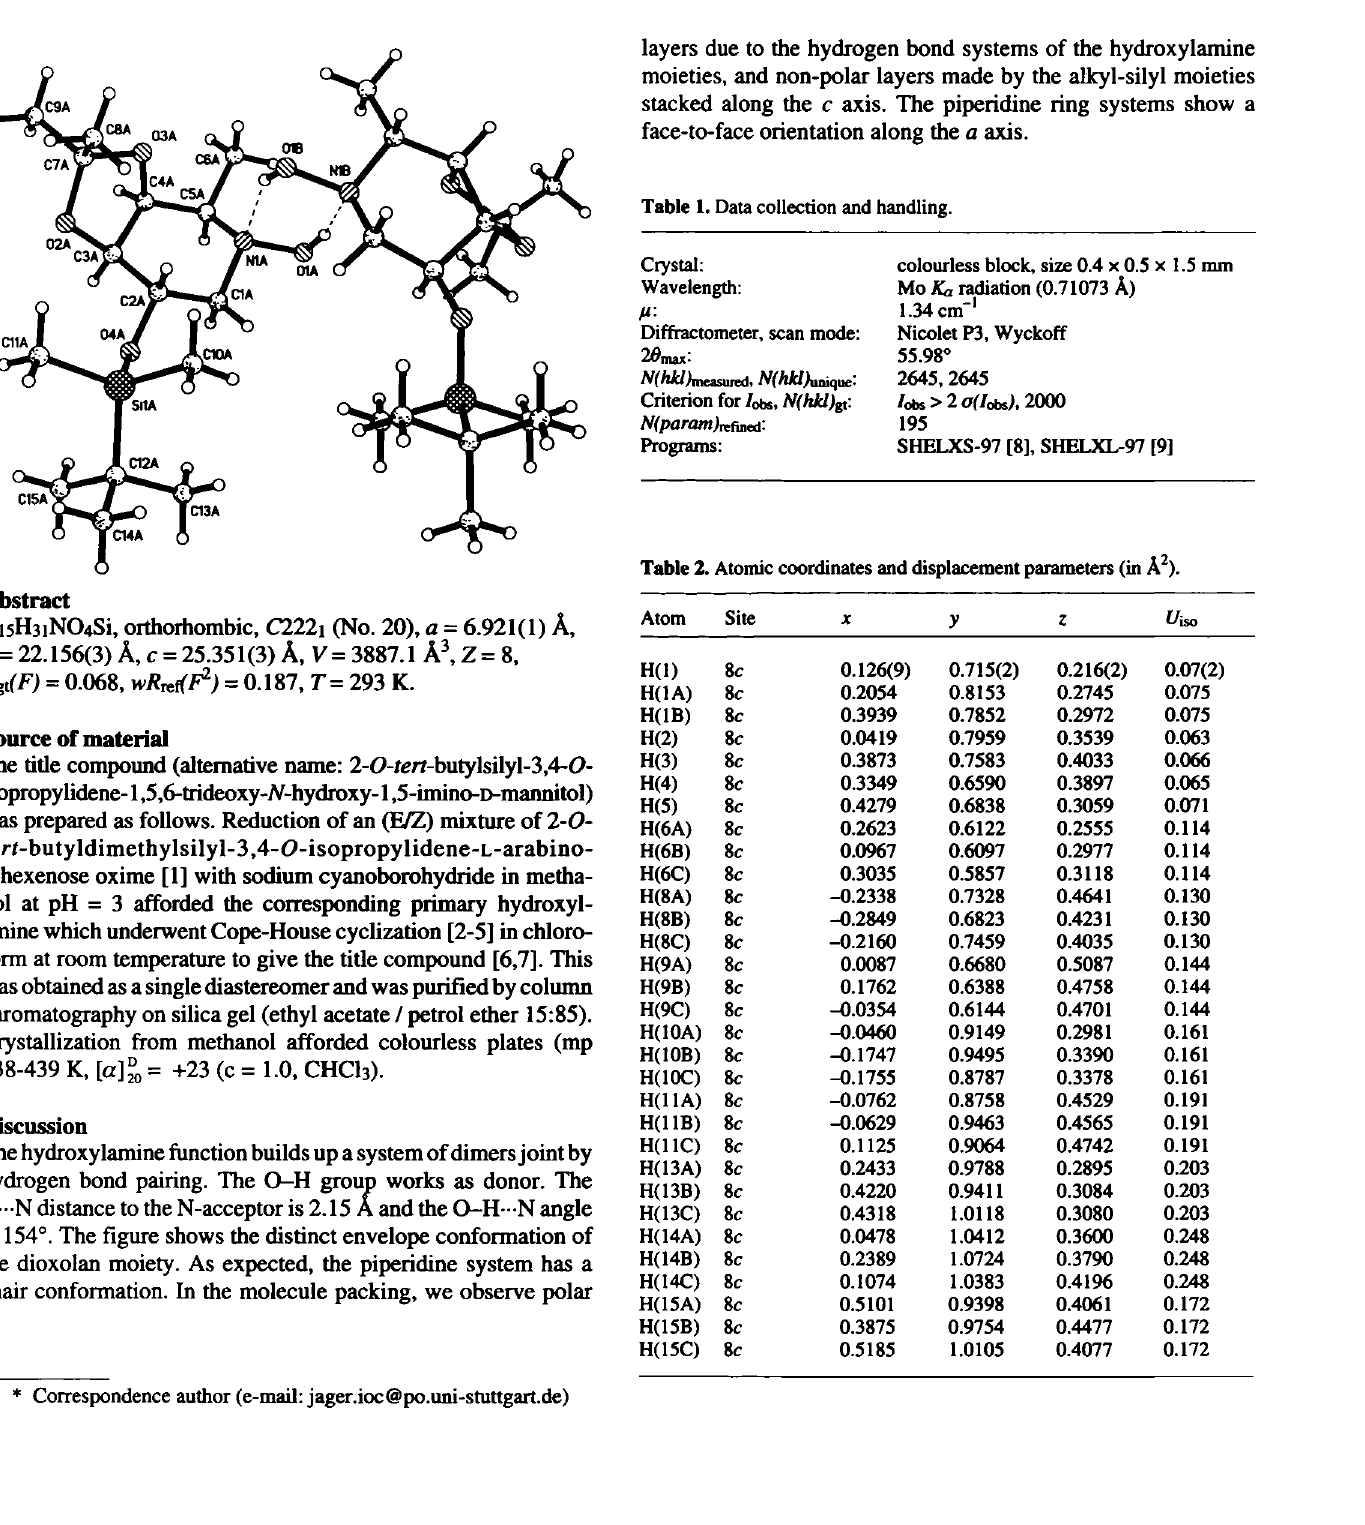
Table I. Data collection and handling.